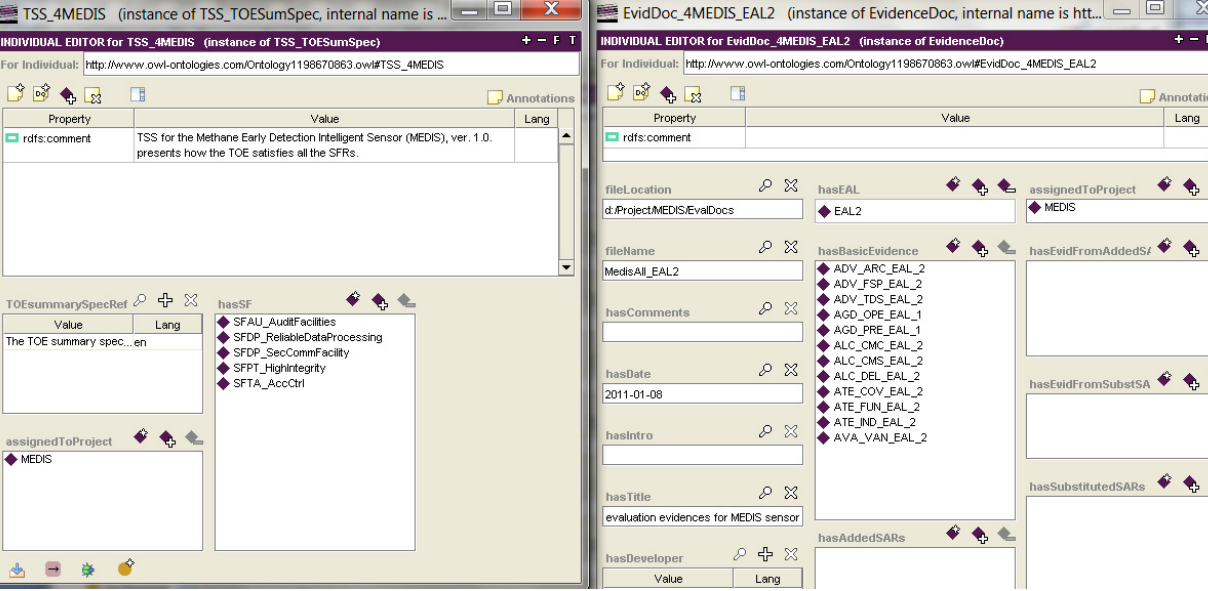
Figure 8. Specifying security functions and evidences